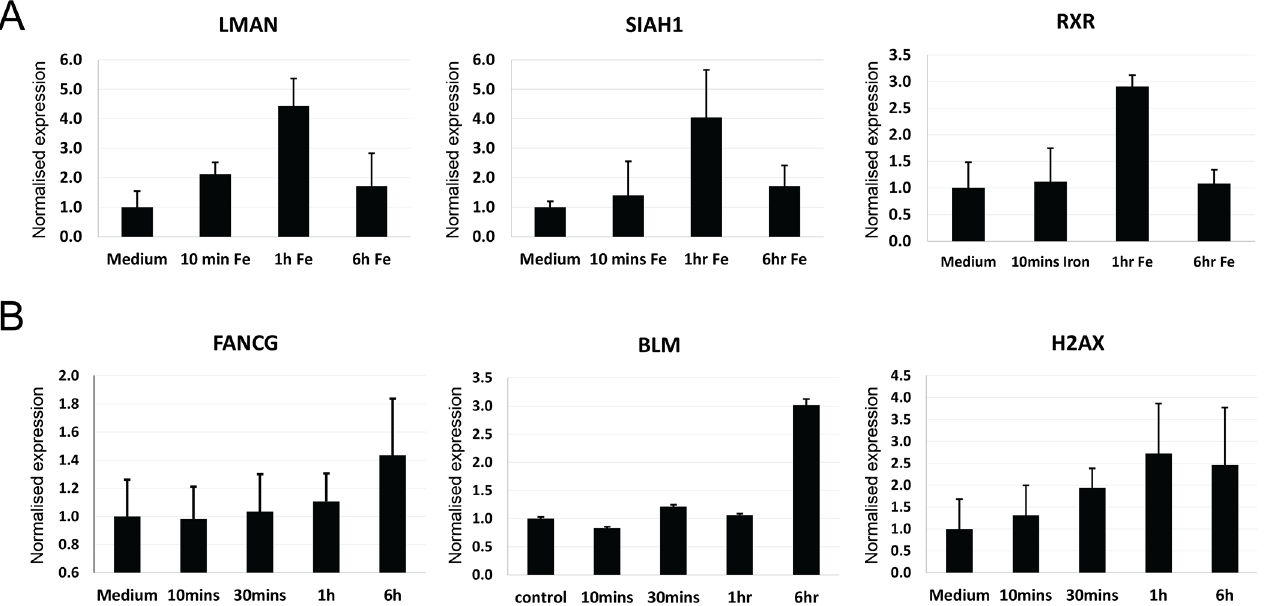
Fig 5. qt-PCR Validations in endothelial cells. A) qt-PCR of key transient early-rising mRNAs in human umbilical vein endothelial cells (HUVEC), selected due to relevant gene ontology processes: LMAN1 encoding lectin, mannose-binding, 1 precursor implicated in tumorigenesis, [42] and also involved in response to wounding, and ER-Golgi recycling; SIAH1 , a tumor suppressor gene which encodes an E3 ubiquitin ligase that can induce apoptosis [43]; and RXRA encoding retinoid X receptor alpha with key roles in cell proliferation, differentiation, and death[44]. B) qt-PCR validations in HUVEC of the key 6 hour genes implicated in DNA repair, FANCG , BLM , and H2AFX